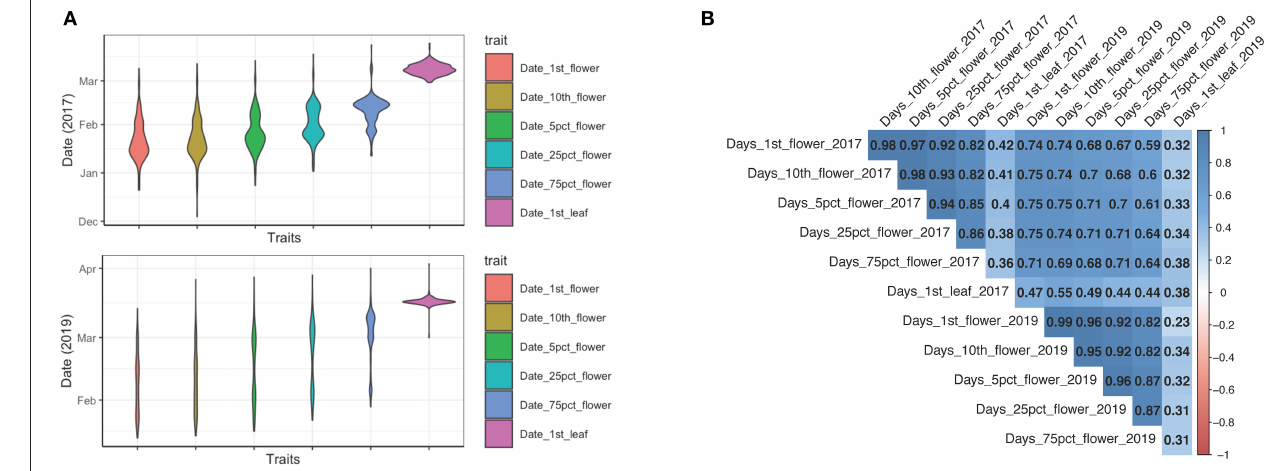
FIGURE 1 | The phenotypic analysis of six phenological traits over 2 years. (A) The violin plot of six traits (date of the first flower, date of the first 10 flowers, date of 5% flowering, date of 25% flowering, date of 75% flowering, and date of leaf flushing) collected in 2017 and 2019. (B) Pearson correlation coefficients among traits in 2017 and 2019. The pair-wise correlations were colored according to the scale bar.